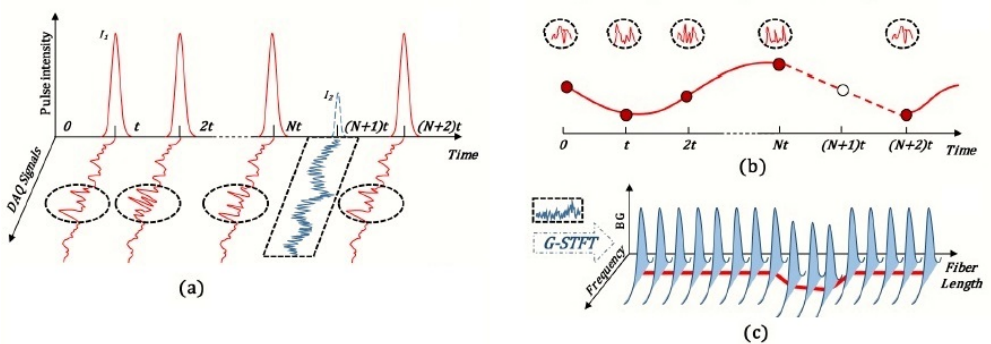
Figure 13. Laser pulse modulation and signal processing of the hybrid distributed multi-parameter sensing system: ( a ) modulated laser sequence and corresponding acquired signal; ( b ) φ -OTDR data processing at the vibration point; ( c ) B-OTDR data processing with Gaussian windowed short time Fourier transform (STFT), BG: Brillouin Gain. (Adapted from [9]).